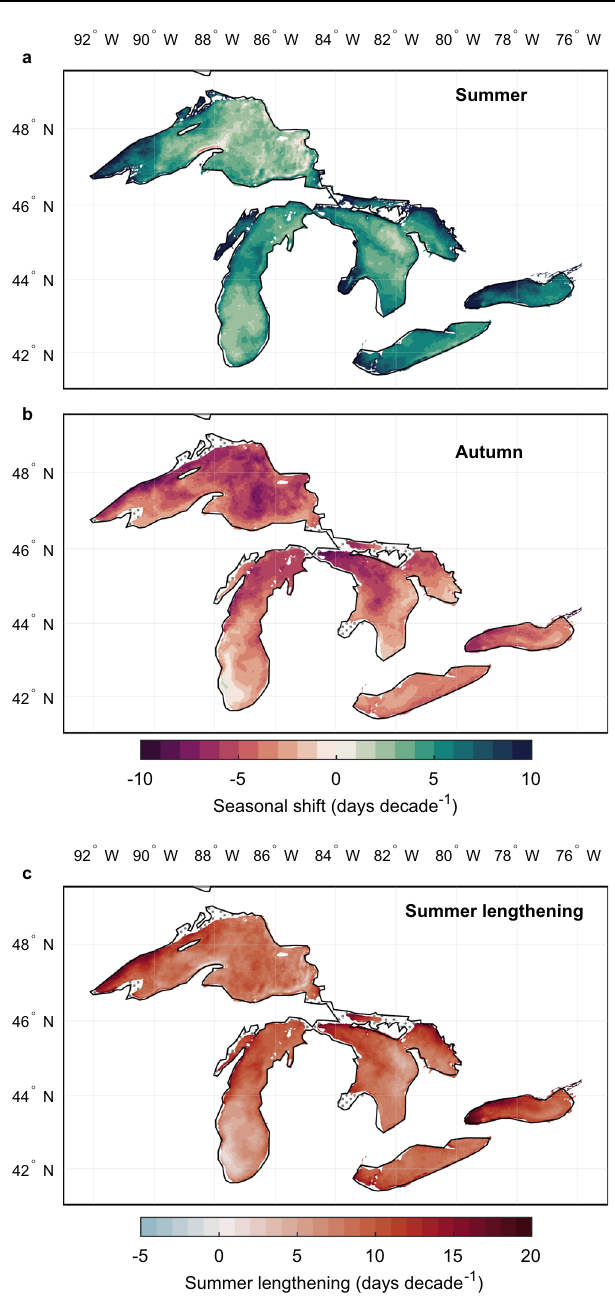
Fig. 3 | The pace of shifting seasons in the North American Great Lakes. Shown aretheseasonalshifts(daysdecade − 1 )inthetimingof( a )summer(June – August)and ( b ) autumn (September – November) temperatures during the satellite data-taking period (1995 – 2021). Positive and negative values indicate when the timing of a sea- sonhasadvancedorbeendelayed,respectively.Alsoshowninpanel c arecalculated changes to the duration of summer, which was estimated as the difference between seasonalshiftsinthestartofsummerandofautumn(asshowninpanels( a )and( b )). Positive and negative values indicate when the summer season has lengthened or shortened, respectively. Stipple markingsrepresents regionsthatwerenotincluded in the analysis, either due to the presence of lake ice cover (grey points) or when lakes experienced a minimal (<0.5°C month − 1 ) seasonal rate of change in surface water temperature (black points) during the season of interest (see Figs. S9 –